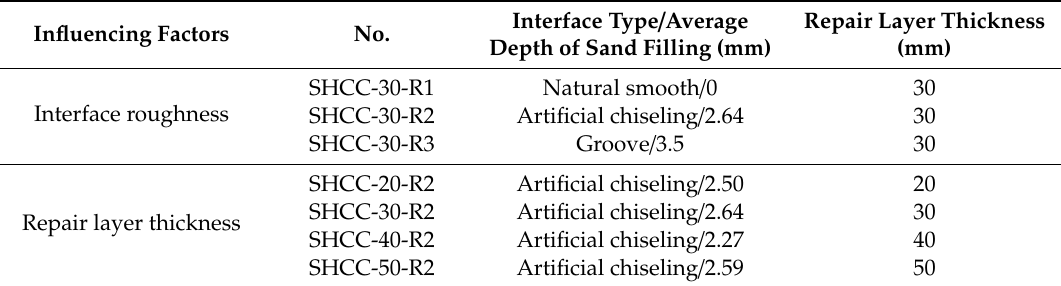
Table 5. Number of SHCC-repaired concrete beams.